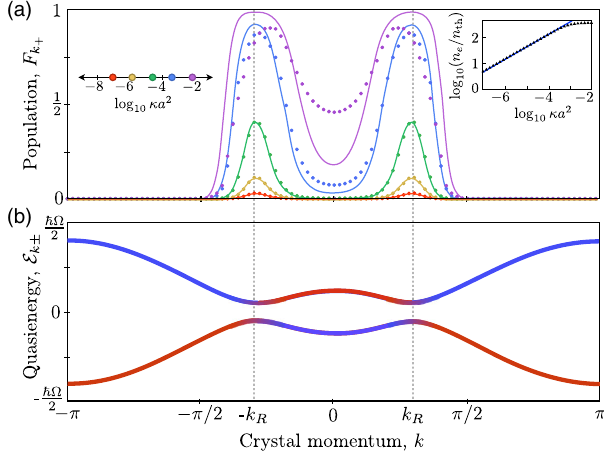
FIG. 3. Numerically obtained steady states with radiative recombination and coupling to acoustic phonons. Here, the density is set to half filling, and we use a 3D acoustic phonon bath with ℏ ω smaller than the gap Δ at the Floquet zone D edge T ¼ 10 − 2 ℏ Ω . We keep edge. The phonon temperature is set to k B the phonon and photon densities of states fixed and only vary an overall scale for the coupling matrix elements. The full details of the model can be found in Table II. (a) Distribution of electrons in f † f the upper Floquet band F for several values of k þ ¼ h k þ i k þ κ ¼ k W rec = π Λ inter ; see Eq. (9) and Appendix C for definitions. R The distributions are fitted to a Floquet Fermi-Dirac distribution at temperature T (solid lines). Because of particle-hole symmetry, the distributions of holes in the lower Floquet band, 1 − F , are k − identical to the distributions shown. Inset: Log-log plot showing the total density of electrons in the upper Floquet band n as a e function of κ . The density n is normalized to the “ thermal e 6 . 8 × 10 − 4 (see the text). The plot demonstrates density ” n th ¼ the square root behavior predicted in Eq. (9). Note that for large n , the recombination rates saturate due to Pauli blocking. The e Floquet band structure is shown in (b).